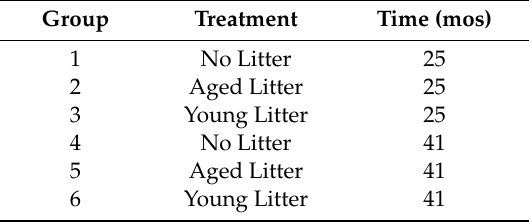
Table 2. Treatment groupings used for field studies and subsequent analyses in this study. Group